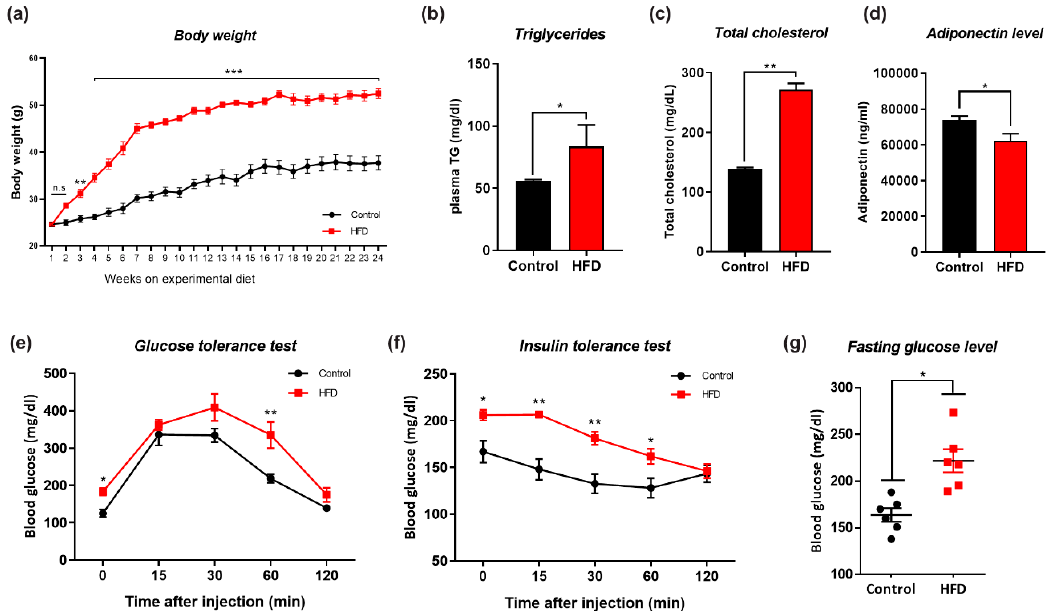
Figure 1. Effects of high fat diet (HFD) on metabolic parameters. Changes in ( a ) Body weight, ( b ) Plasma triglyceride levels, ( c ) Plasma total cholesterol level, ( d ) Plasma adiponectin level, ( e ) Glucose tolerance test, (GTT), ( f ) Insulin tolerance test, (ITT), ( g ) Fasting glucose between normal chow diet (NCD) and HFD fed experimental mice groups. (n = 12 mice/group). Data are presented as mean ± SEM and were analyzed using one-way ANOVAs between NCD and HFD mice groups. Significance = * p < 0.05, ** p < 0.01, *** p < 0.001.